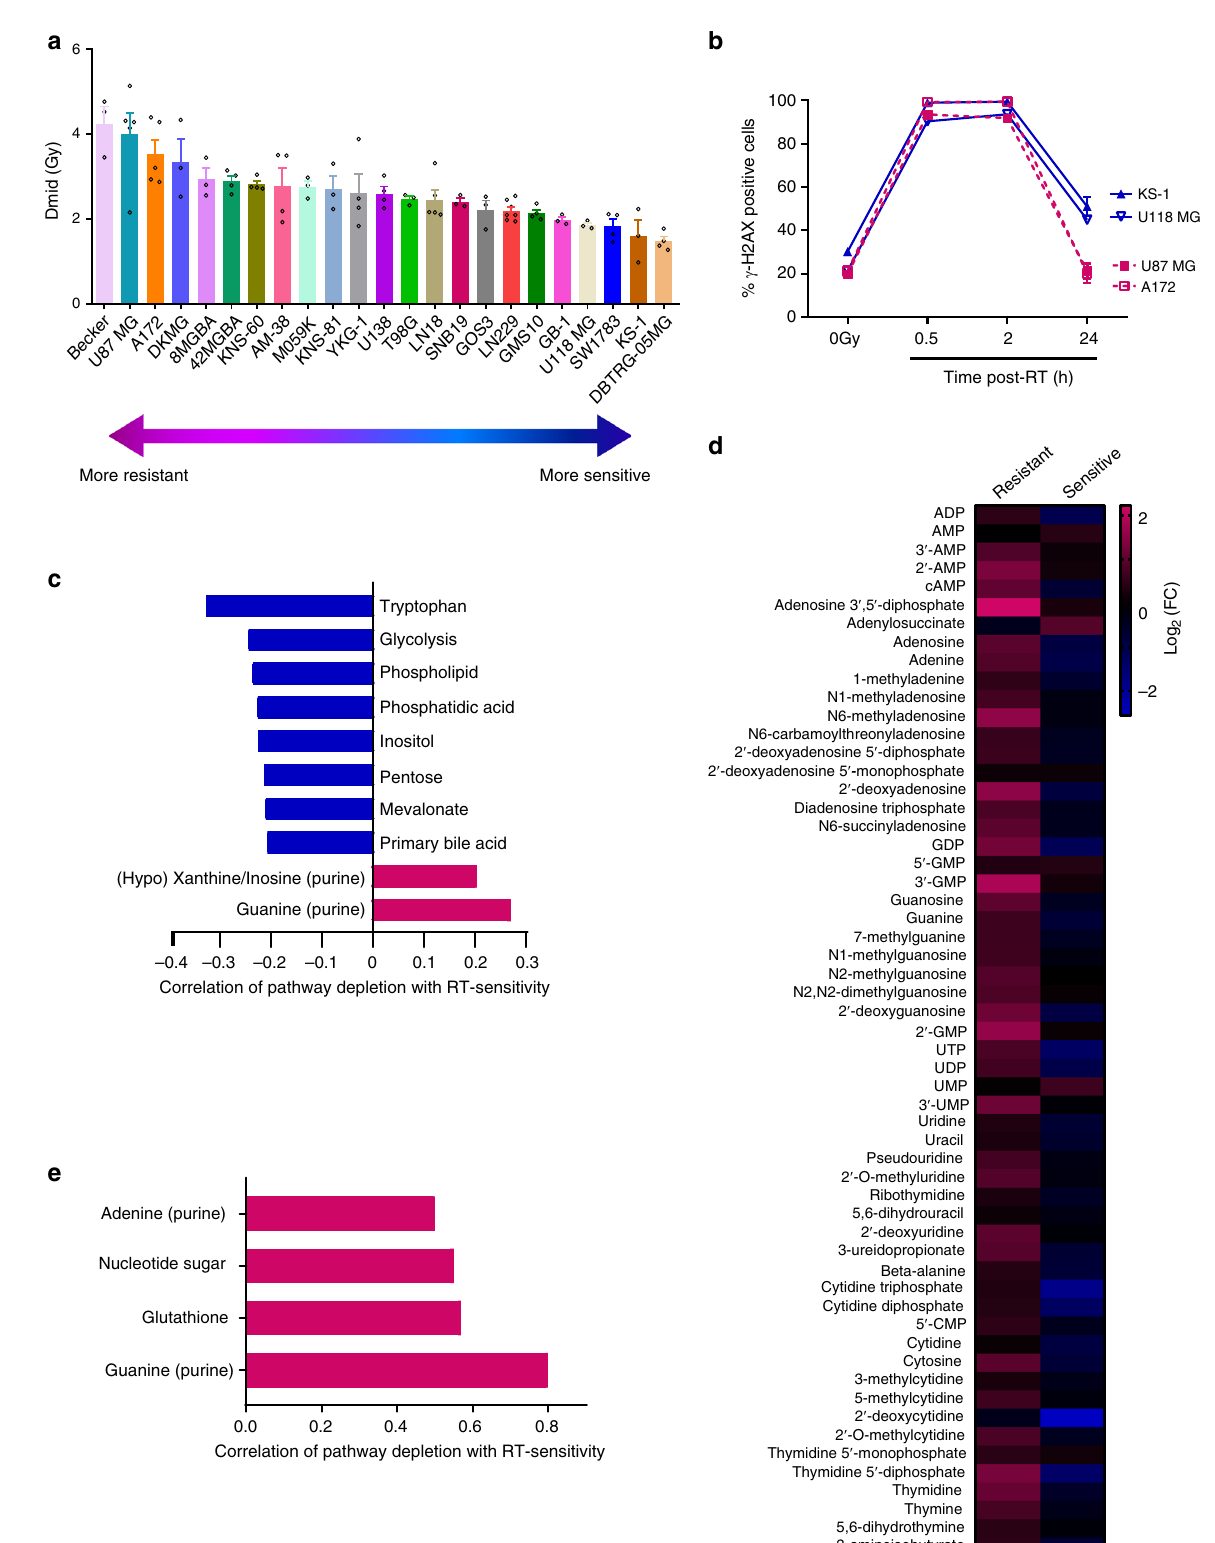
and GB-1; Fig. 1a) were protected from RT by exogenous nucleosides with Enhancement Ratios (ERs) ranging between 0.6 and 0.8 (Fig. 2b – d). ER of RT is de fi ned as Dmid control divided by Dmid treatment. ERs below 1 indicate radioprotection and above 1 indicate radiosensitization. The RT-protection conferred by nucleosides was associated with decreased RT-induced